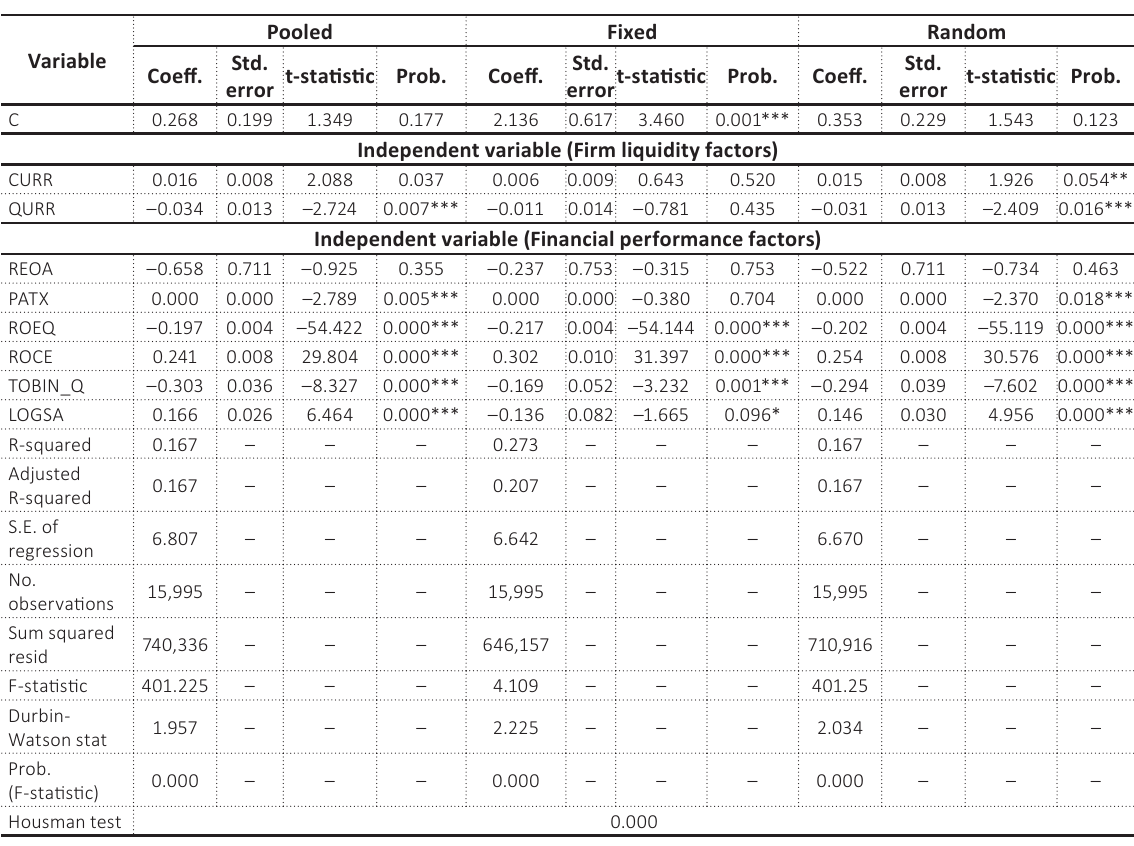
Table 5. Regression analysis